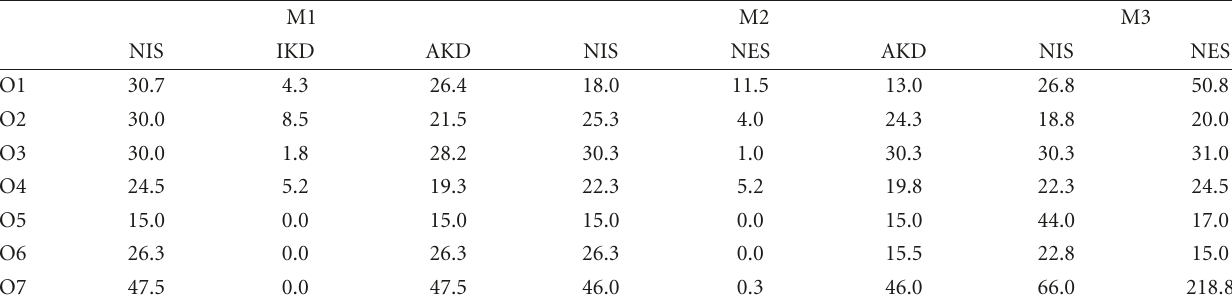
Table 4: Average numbers of internal seeds (NIS), interactive κ s detections (IKD), external seeds (NES), and automatic κ s detections